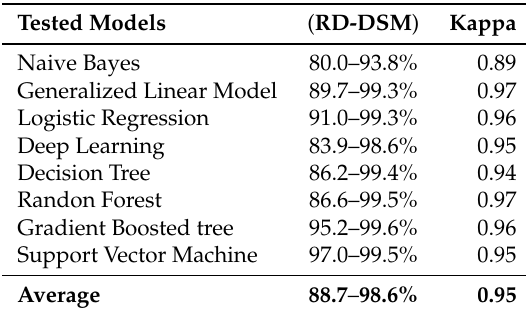
Table 4. Concordance.